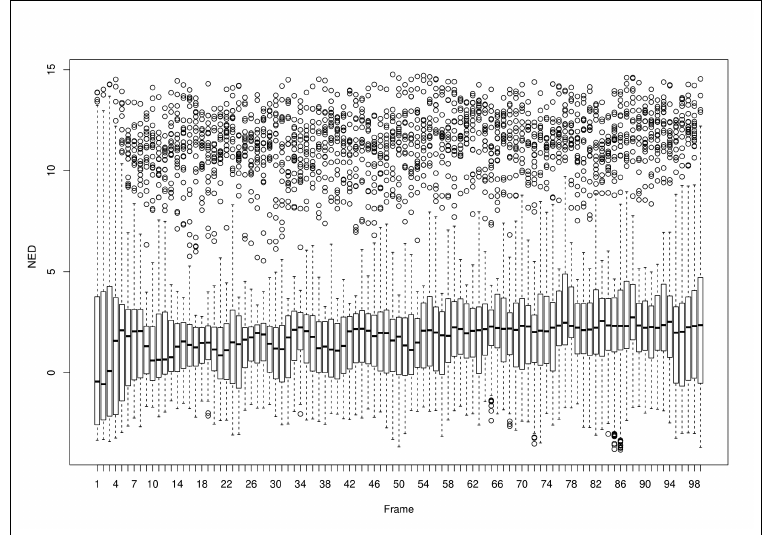
Figure 5. Boxplot of first 100 frames’ NED of audio files for congruent readings.